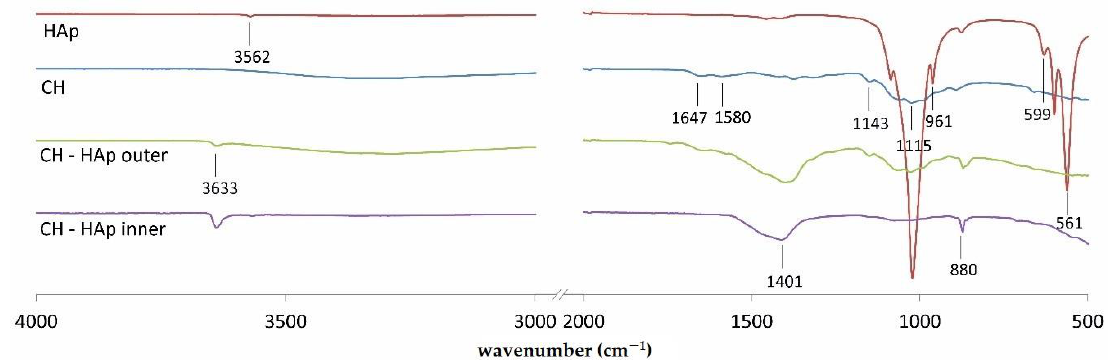
Figure 6. FTIR spectra of native chitosan, hydroxyapatite, and surfaces (inner and outer) of deposit obtained from the chitosan-hydroxyapatite colloidal solution for the electrodeposition process initiated at 12 V after 40 min.